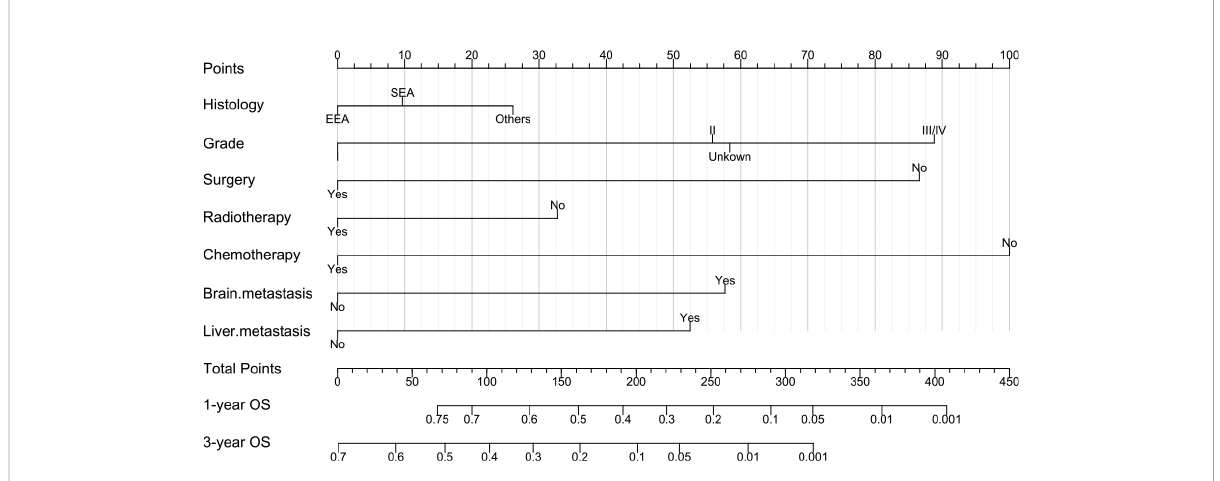
FIGURE 1 Nomogram to predict the 1-year and 3-year overall survival (OS) of EC patients with lung metastasis. EEA, endometrial endometrioid adenocarcinoma; SEA, serous endometrioid